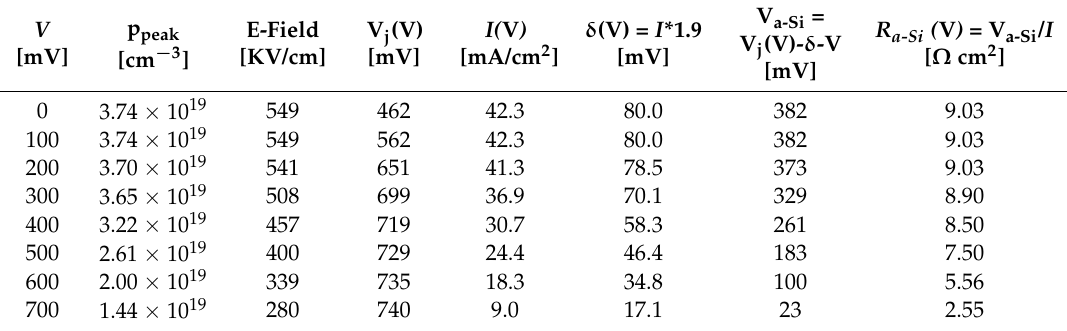
Table 5. Dependence of R a-Si in cell SHJ 1 on forward